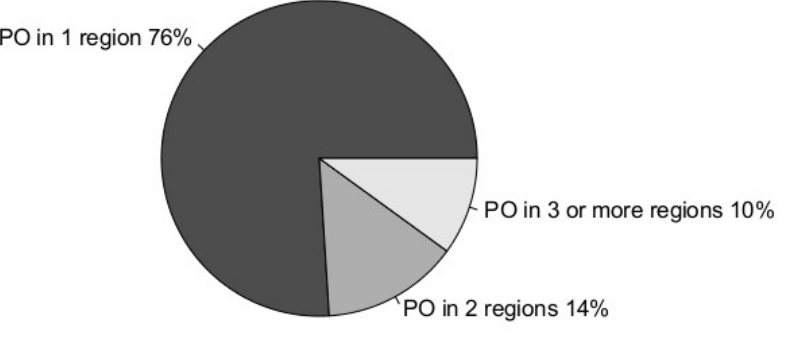
Figure 3. Location of partner organisations (PO) in museum university partnerships as shown by survey data. The graph indicates the number of partners in every region of